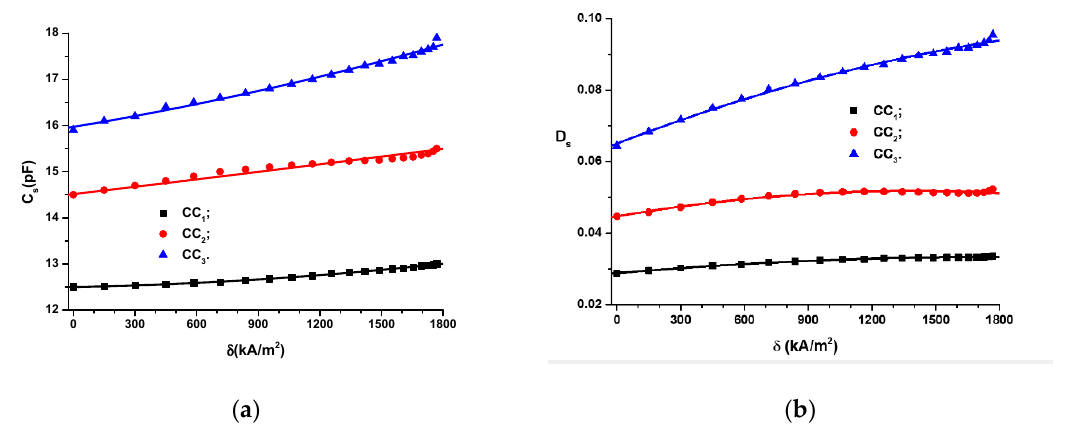
Figure 8. ( a ) The electric capacitance, C s , vs. the magnetic field intensity gradient, δ , for different volumetric fractions; ( b ) the tangent of the dielectric loss, D s , vs. the magnetic field intensity gradient, δ , for different volumetric fractions (dots are experimental data, and lines are the second-order polynomial fit).